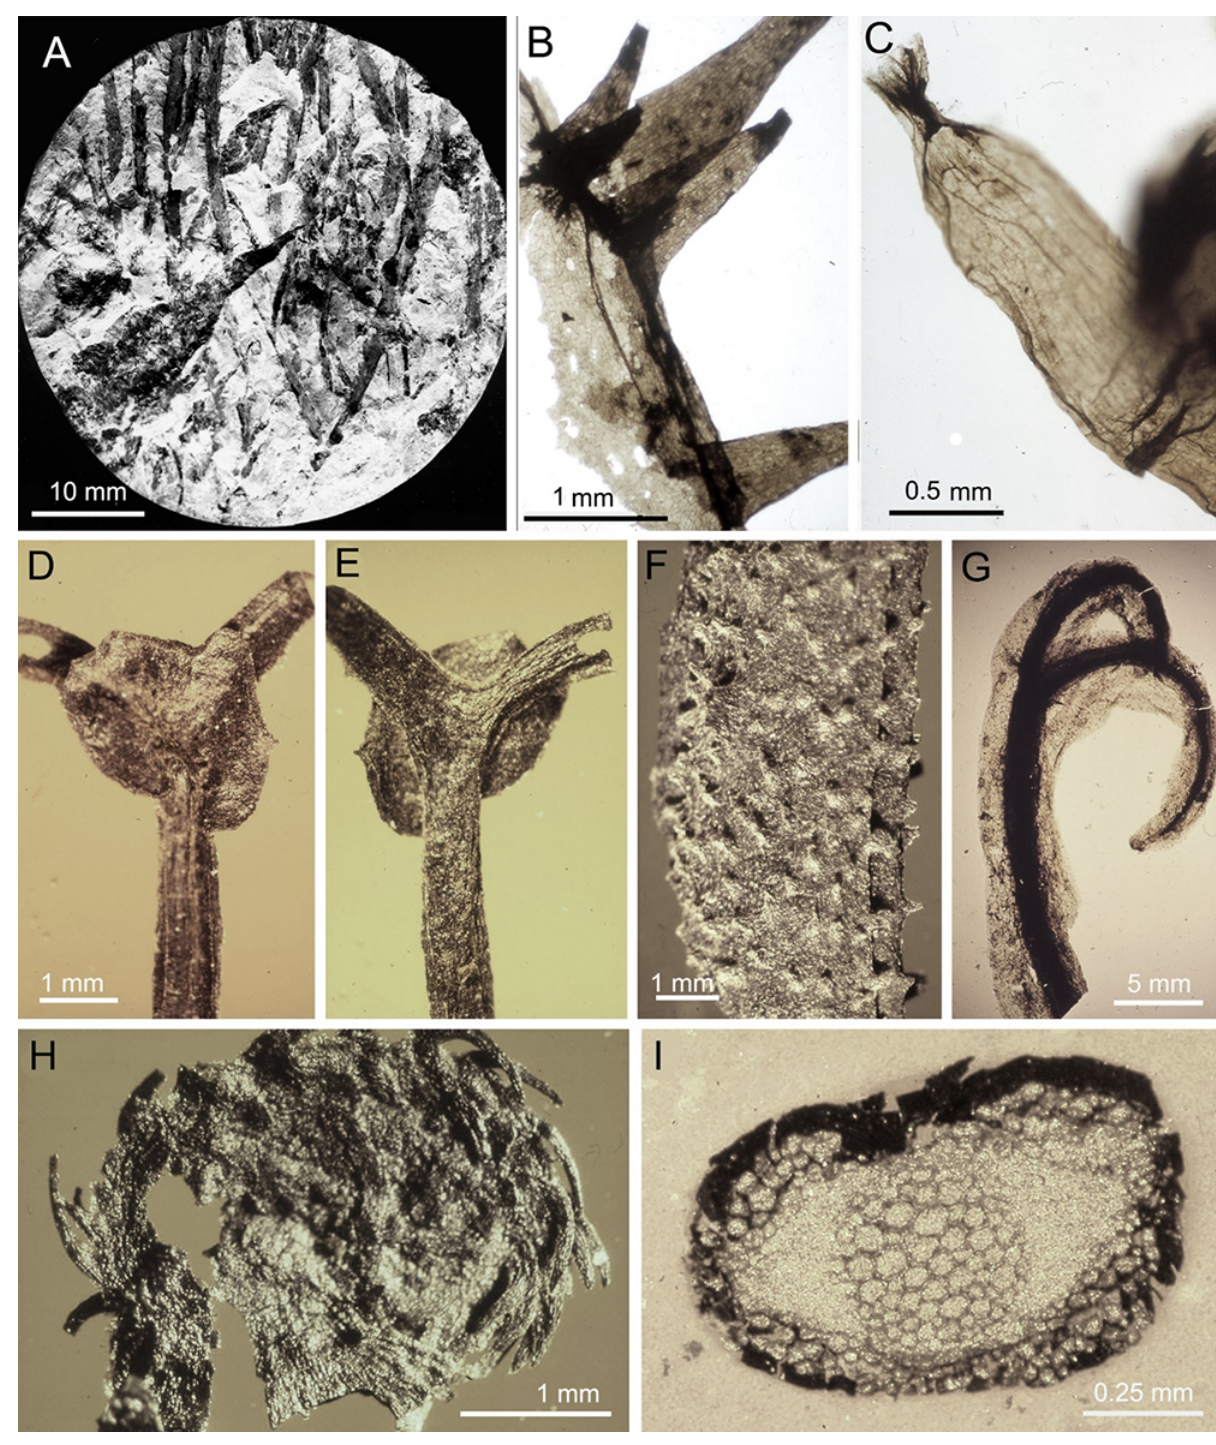
Figure 3 Early Devonian (Emsian) zosterophyllophytes from Poland. Sawdonia ornata , Opole Lubelskie 3 borehole: ( A ) Core fragment with numerous axes covered with spines, hand specimen 16; ( B ) Fragment of shoot epidermis with spines, slide 17/10; ( C ) Spine with widened vesicular end which is open, slide 17/2. Konioria andrychoviensis , Andrychów 2 and Andrychów 4 boreholes: ( D,E ) Fragment of axis with sporangium situated at the level of a dichotomy (both sides), S/98/31; ( F ) External surface of a pyritized axis with numerous short spines, S/98/23; ( G ) Shoot apex showing dark core and stomata as dark spots, S/98/29; ( H ) Circinately coiled young axis densely covered with long spines, S/98/25; ( I ) Transverse section of axis showing xylem strand, specimen unnumbered. All specimens stored in Palaeobotanical Collection, Institute of Botany, Jagiellonian University (abbreviated as PC IB UJ) (photos by D.